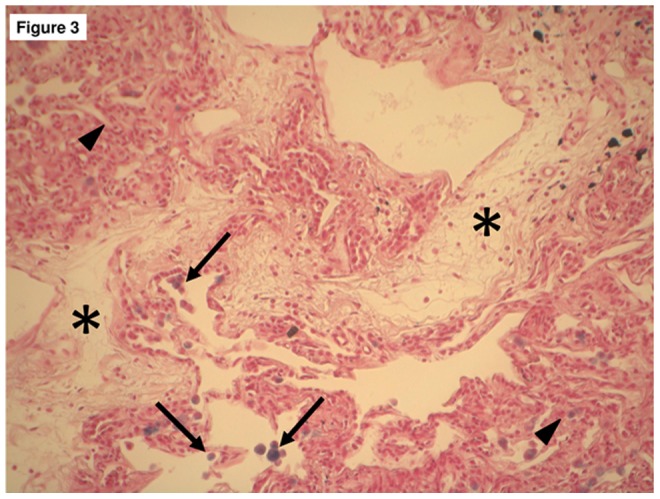
Histologic specimen from a patient suffering from PVOD who underwent lung transplantation.Intimal thickening and fibrous obstruction of septal veins and preseptal venules (asterixis) as well as features of pulmonary capillary hemangiomatosis with proliferation of dilated and congested capillaries as well as dilated lymphatic (left upper and right lower part of the figure; arrowhead). Alveoli with haemosiderin-laden macrophages of Golde score 3–4 (arrow) are clearly visible. Haemosiderin-negativ macrophages are difficult to be identified. Golde score from the tissue was 304, as compared to 252 in the sputum.